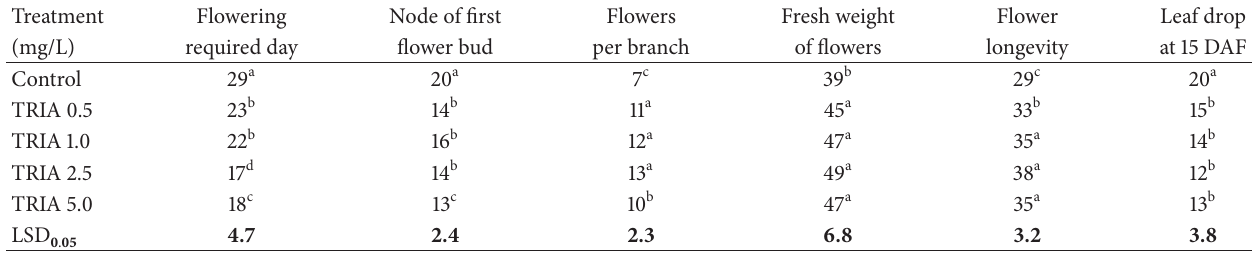
Figure 4: The effect of TRIA treatment on the net photosynthesis rate of Bougainvillea glabra under natural conditions. Table 4: The effect of TRIA treatments on flowering initiation, quality, and the abscission of bracts and leaves of Bougainvillea glabra under natural